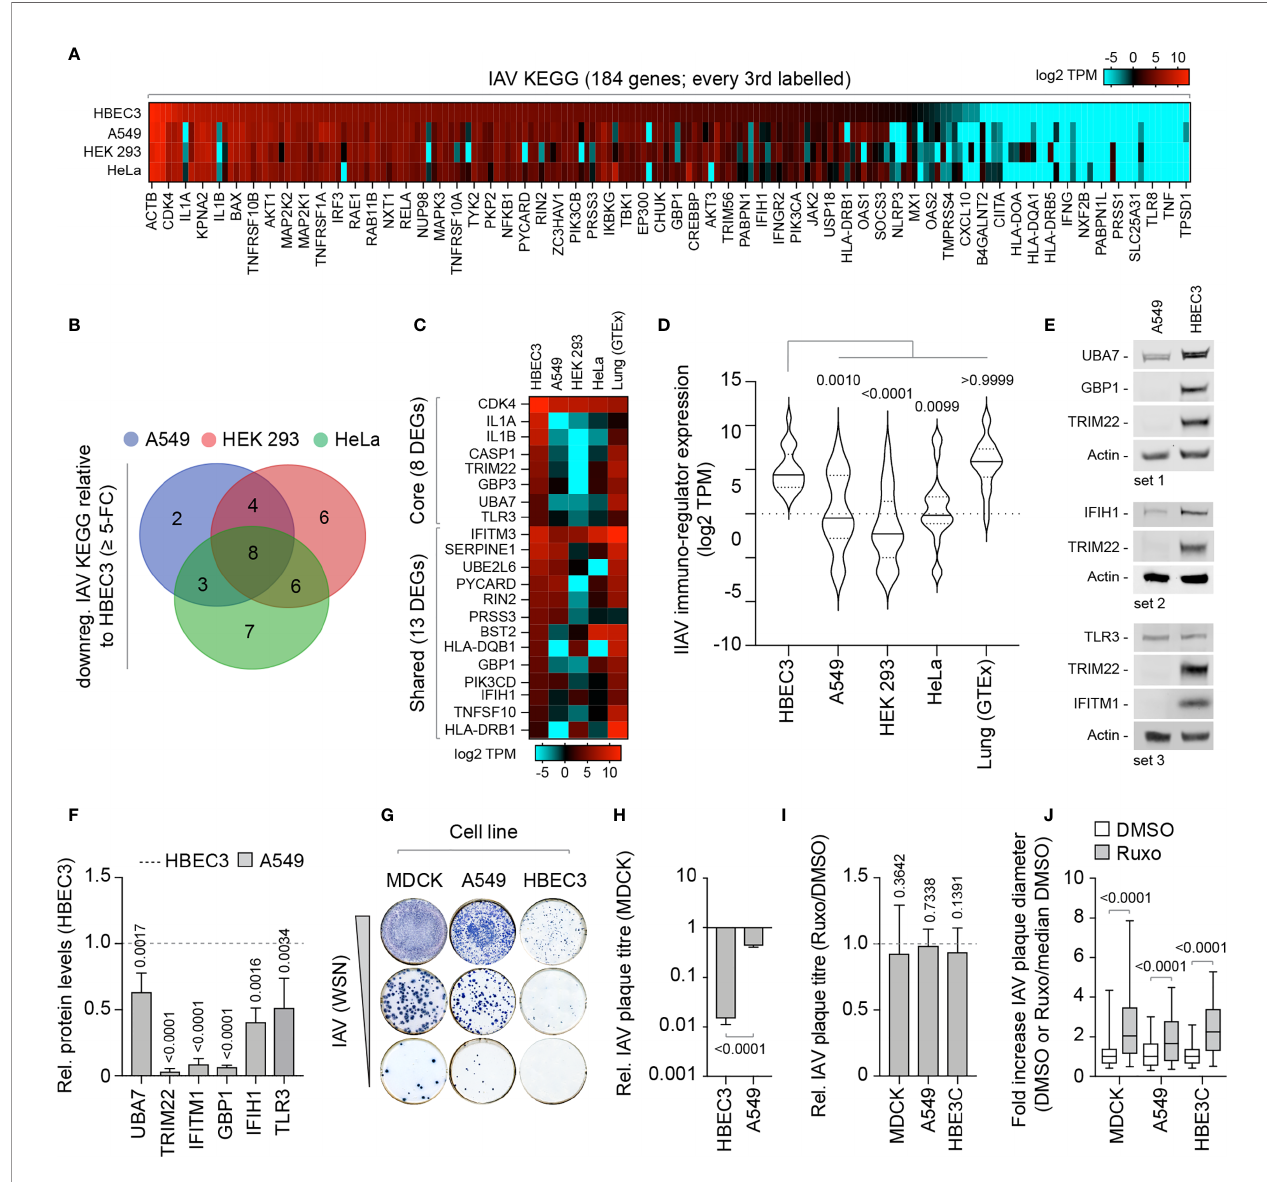
FIGURE 7 | Laboratory-adapted cell lines show enhanced permissivity to IAV infection. (A) Heat map showing the expression pro fi le (log2 TPM) of genes associated with an extended IAV KEGG network [hsa05164; (Villalon-Letelier et al., 2017)] in HBEC3, A549, HEK 293, and HeLa cells. Every second gene labelled. Values shown in Supplemental Table S4A . (B) Venn diagram showing the number of unique and shared DEGs identi fi ed to be downregulated ( ≥ 5-fold change) in A549, HEK 293, and HeLa cells ( ≤ 4 TPM) relative to HBEC3 cells ( ≥ 3 TPM per gene) for each paired condition analyzed. (C) Heat map showing expression pro fi le (log2 TPM) of conserved (core, 8 genes) and shared (13 genes) DEGs identi fi ed to be downregulated in A549, HEK 293, and HeLa cells relative to HBEC3 cells (as in B ) and associated values in lung tissue (GTEx, n=427). Values shown in Supplemental Table S4B . (D) Violin plot showing the expression pro fi le of downregulated IAV KEGG DEGs (as in C ). Horizontal solid lines; median gene expression. Horizontal dotted lines; 5 th and 95 th percentile range. Paired one-way ANOVA (Friedman multiple comparison test); p-values shown. (A – D) Data adapted under creative commons licence from HPA and GTEx portal, respectively (Uhlen et al., 2010; Carithers et al., 2015; Uhlen et al., 2015). (E) Western blots of WCLs derived from non-treated HBEC3 and A549 cells showing UBA7, GBP1, IFIH1, TLR3, IFITM1, and TRIM22 (+ve control) protein expression levels. Actin is shown as a loading control. (F) Quantitation of protein expression levels (as in E ). Values normalized to actin and expressed relative to levels in HBEC3 cells (Dotted line). n ≥ 3, means and SD shown. One-sample two-tailed t test against a hypothetical mean of 1; p-values shown. (G) Representative immunocytochemistry images of IAV plaque formation (NP staining) in MDCK, A549, and HBEC3 cells infected with equivalent serial dilutions of IAV (WSN). (H) Quantitation of plaque numbers in each cell line expressed relative (rel.) to MDCK cells (rel. plaque titre); n ≥ 3, means and SD shown. Mann-Whitney U-test; p-value shown. (I) MDCK, A549, and HBEC3 cells were pre-treated for 1 h in the presence of Ruxolitinib (Ruxo; 5 µM) or DMSO (carrier control) prior to infection with serial dilutions of IAV (WSN) in the presence of drug or carrier control. Quantitation of rel. plaque titre (plaque titre with Ruxo/plaque titre with DMSO) for each cell line is shown. n ≥ 3, means and SD shown. One-sample two-tailed t test against a hypothetical mean of 1; p-values shown. (J) Quantitation of the fold increase in IAV plaque diameter in Ruxo or DMSO-treated infected cell monolayers (as in I ). Values normalized to the median DMSO plaque diameter in each cell line (DMSO or Ruxo/median DMSO). n ≥ 3, means and SD shown. Mann-Whitney U-test; p-values